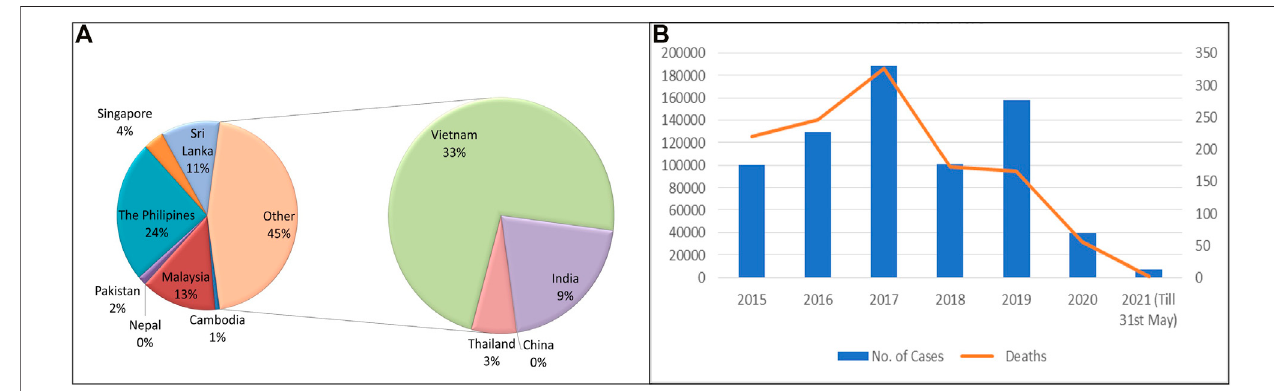
FIGURE 3 | (A) Comparative analysis of dengue incidences in different Asian countries (Source: WHO and European Center for disease Prevention and Control). (B) Number of dengue cases and deaths in India (2015 – 2021 May). (Source: National Vector Borne disease Control Programme).